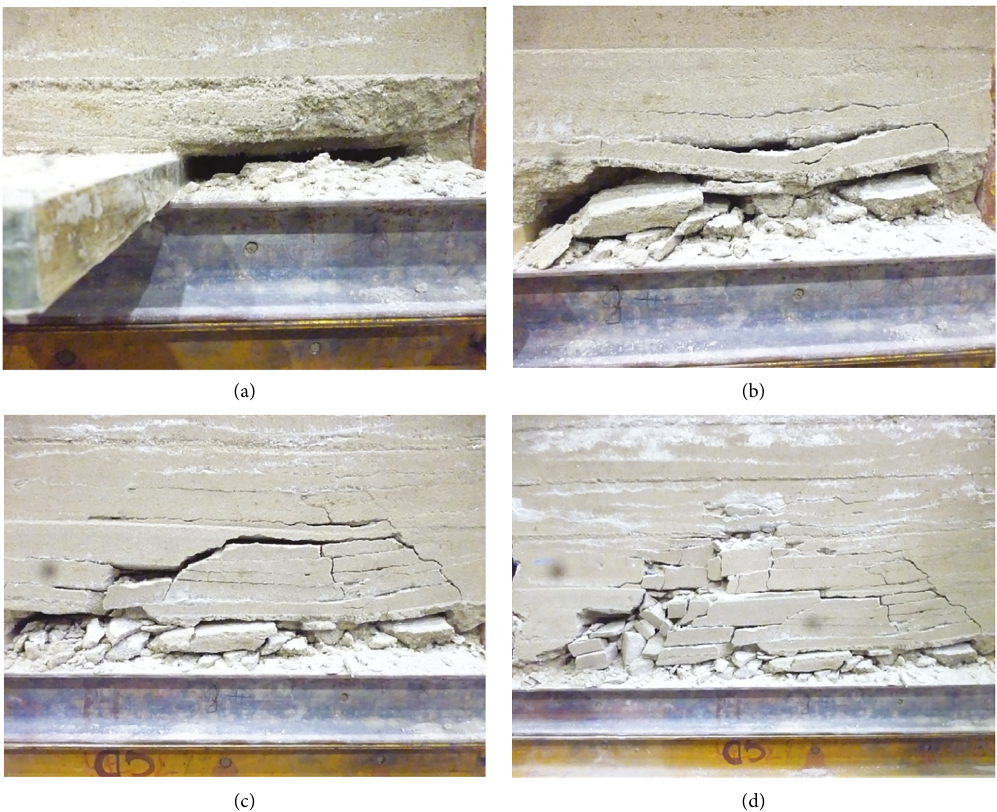
Figure 6: External failure form of overlying rock in reverse knife handle working face. (a) Mining 30 m. (b) Mining 60m. (c) Mining 90m. (d) Mining